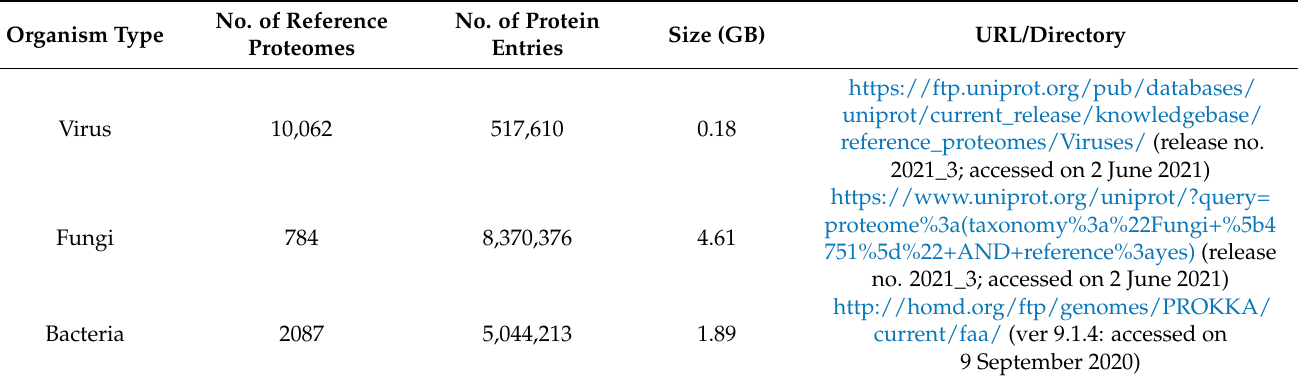
Table 2. Microbial reference database details: Information regarding reference database sources, including number of entries, size, URL, and version